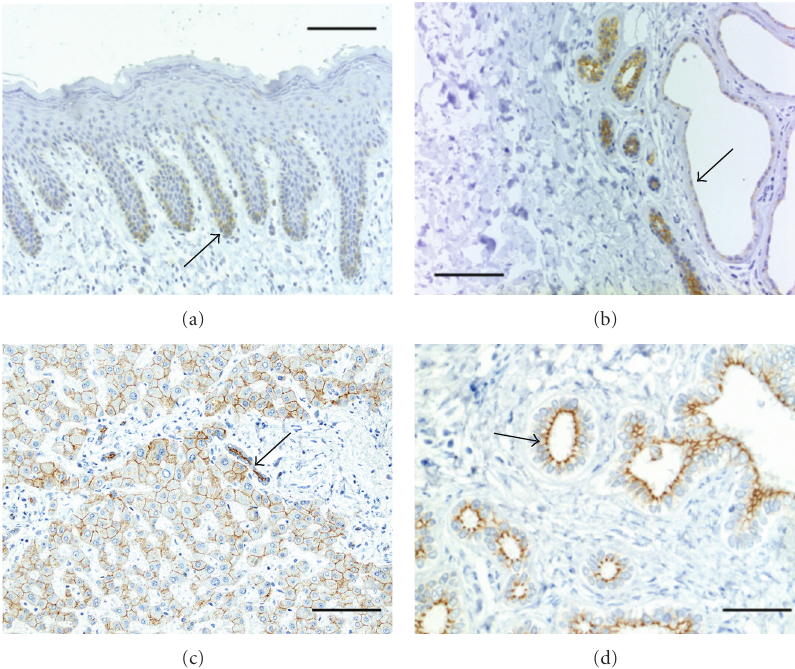
Figure 3: Immunohistochemical staining of sections of human skin a, and b and liver c, and d with antibodies against PKP 2. (a) The staining of samples of human skin with a monoclonal antibody against PKP 2 (clone PP2-150; Progen, Heidelberg) demonstrates a weak and delicate desmosomal staining as well as cytoplasmic staining in the basal layer of the interfollicular epidermis (arrow). Suprabasal keratinocytes remain unstained. (b) Eccrine sweat glands and ducts show a strong reaction with PKP 2-specific antibodies while apocrine sweat glands exhibit an apical, distinct but weak desmosomal reaction (arrow). (c) Hepatocytes as well as bile ductules are marked at the cell-cell contacts by PKP 2-specific antibodies (arrow). (d) Bile ducts also show a sharp and apical staining of desmosomal structure by the PKP 2-antibodies. The samples shown in (c) and (d) are derived from liver tissue in the vicinity of a metastasis of a gastrointestinal stromal tumor with portal and periportal fibrosis and ductal and ductular proliferation. Scale bars: 100 μ m (d), 200 μ m (a, b,